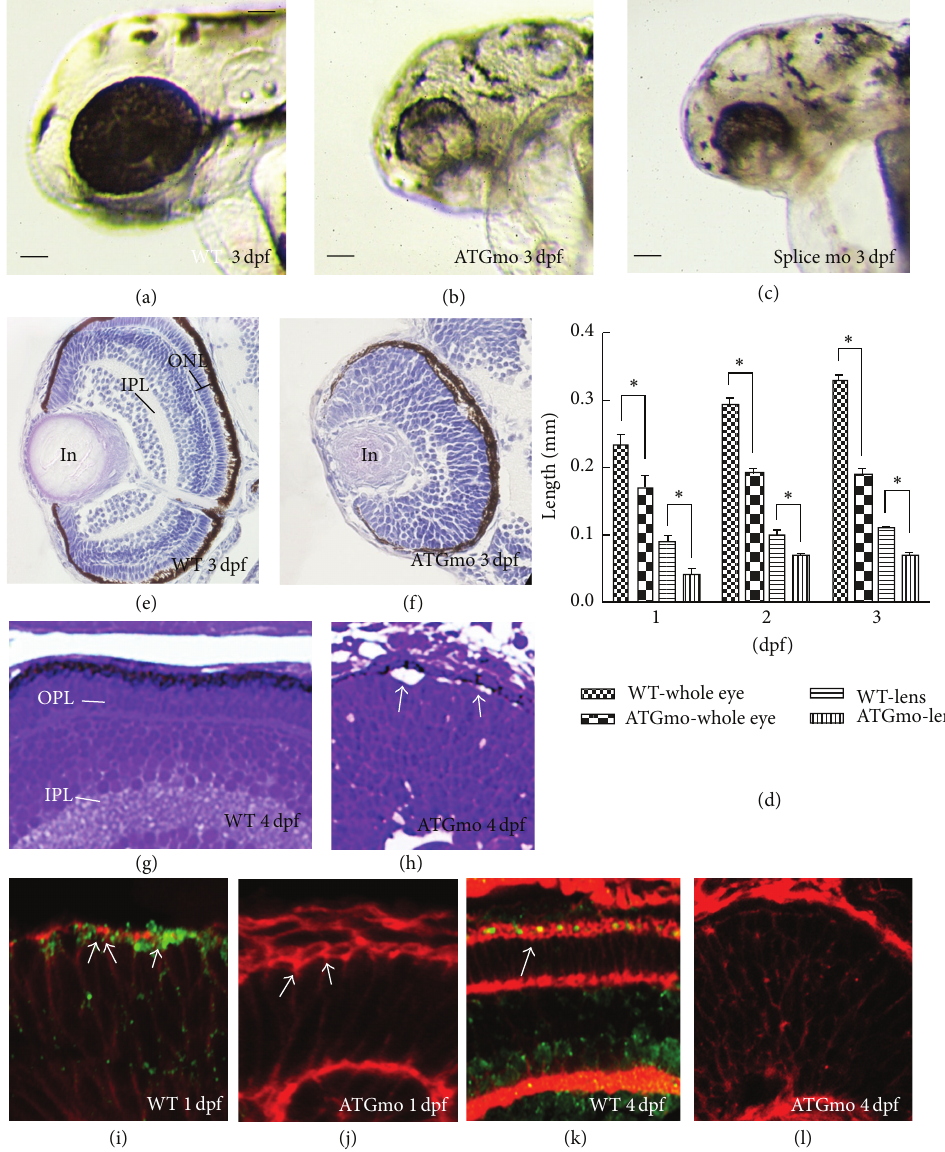
Figure 2: Zbves morphants exhibited defects in eye size and lamination. The morphological observations of wild-type and ATGmo- and splice mo-injected embryos are shown. Compared with wild-type (a), the eyes formed abnormally and resulted in microphthalmos after knockdown of zBves (b), (c). Statistical analyses of the length of whole eye and lens in both groups were performed ( 𝑛 = 11 , t -test for two groups, 𝑃 < 0.01 ) (d). HE staining in paraffin sections of wild-type and morphant embryos revealed the eye without a laminated retina (e), (f). The same patterns were observed in the semithin Epon sections with toluidine blue staining (g), (h). Scale bar, 50 𝜇 m. Immunostaining with anti-zBves antibody (green) and phalloidin (red) was performed in the retinal neuroepithelia of wild-type (i) and zBves MO-treated embryos (j) at 24 hpf and laminated retinas of untreated (k) and zBves MO-treated embryos (l) at 96hpf. ln, lens. Scale bar, 10 𝜇